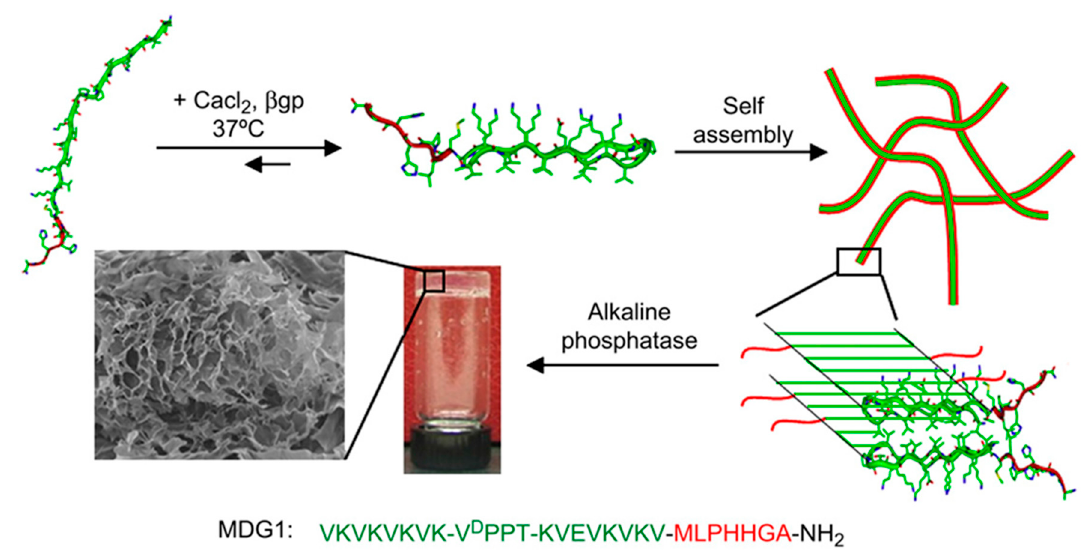
Figure 7. Scheme showing the self-assembly of MDG1 and the formation of three-dimensional gels after mineralization. Reproduced from [121].